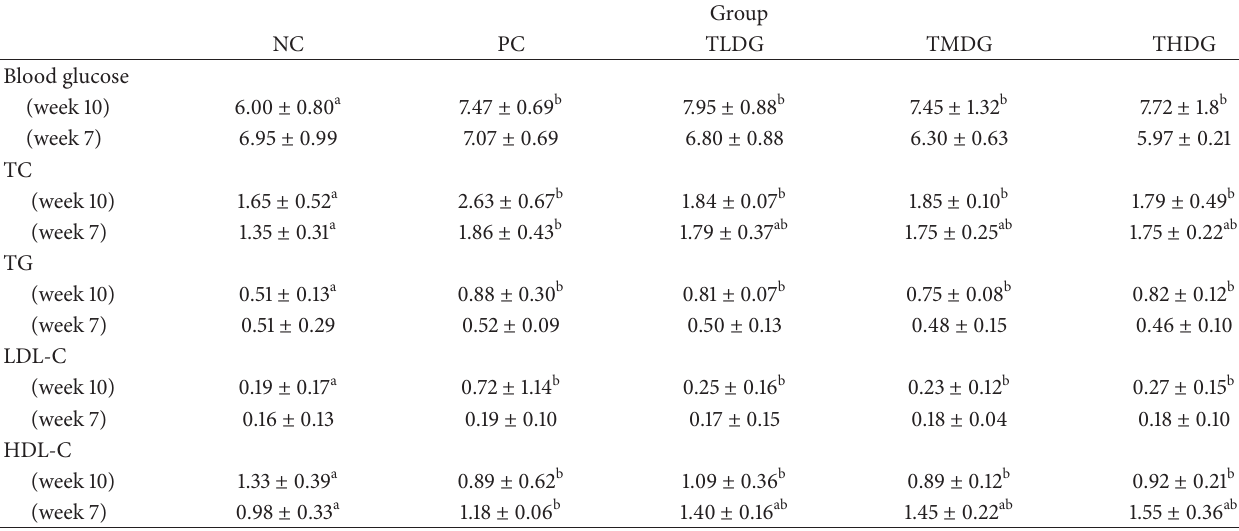
Table 4: Mean of blood glucose and lipid profile of rats after obesity induction (week 10) and after treatment (week 7).